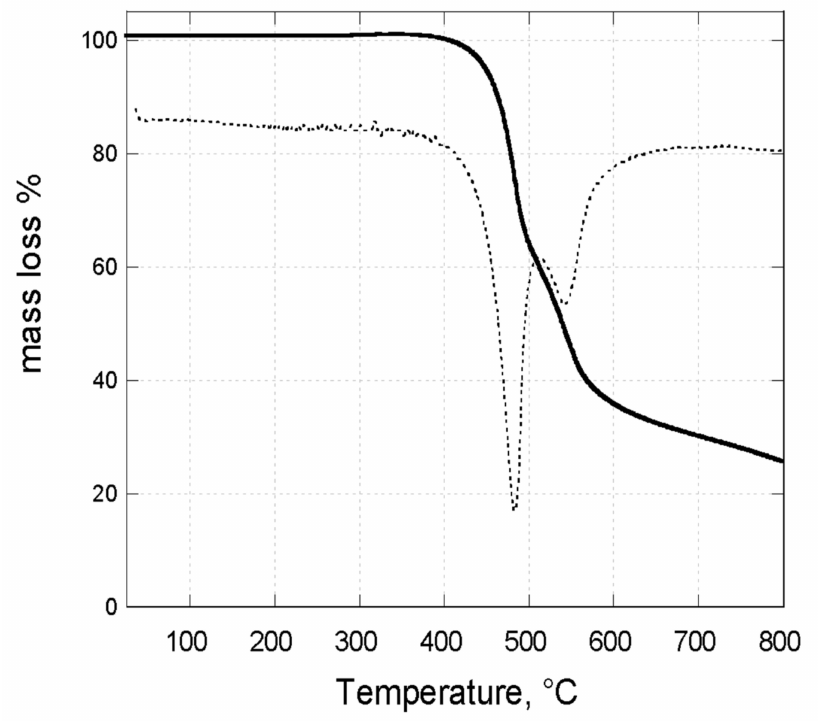
Figure 3. TG (line) and dTG (dashed line) curves of the [Zn(4,4 (cid:48) -bipy)Cl 2 ] ∞ sample.